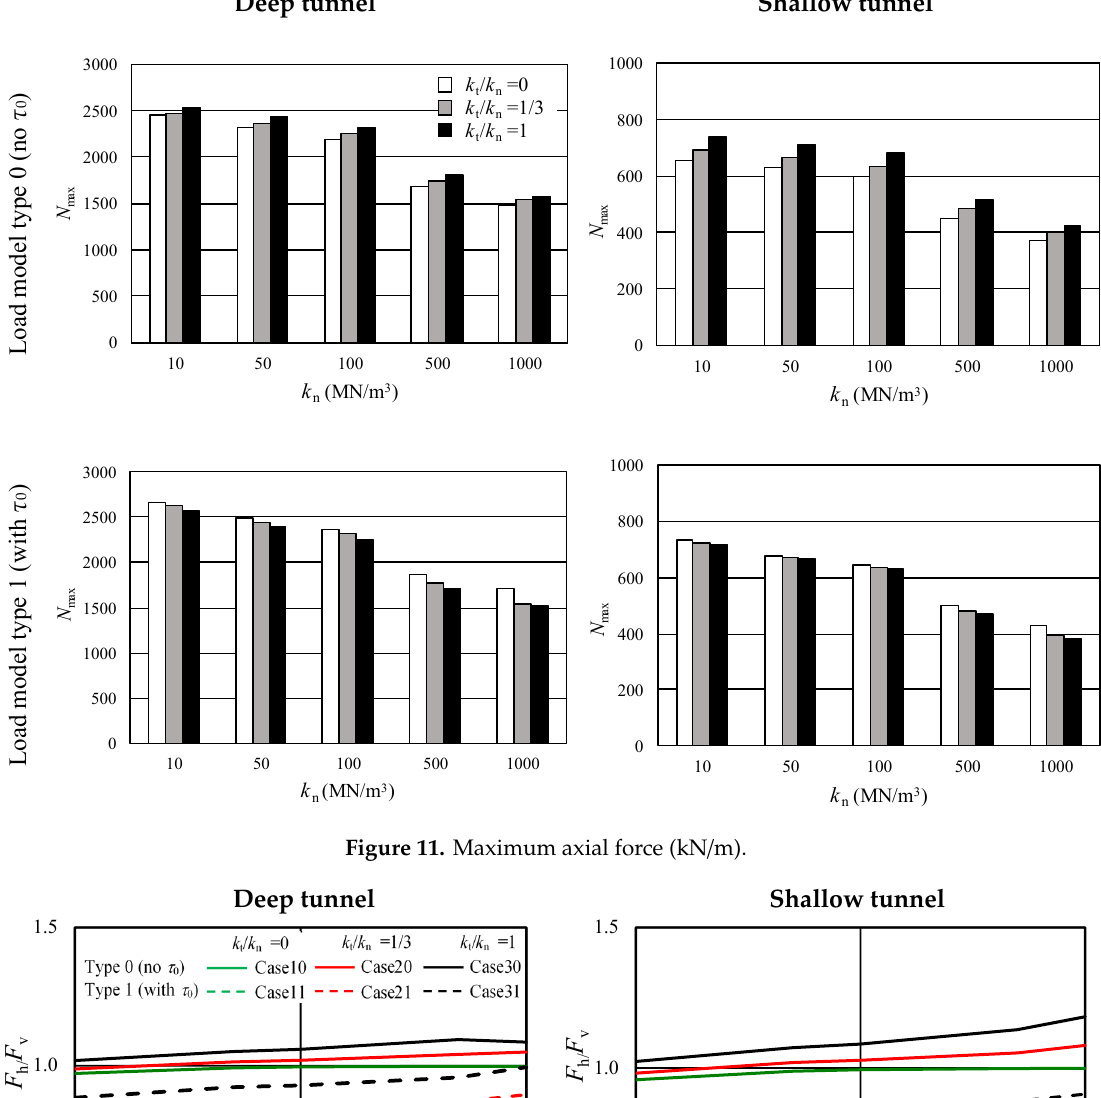
Figure 12. F h / F v .